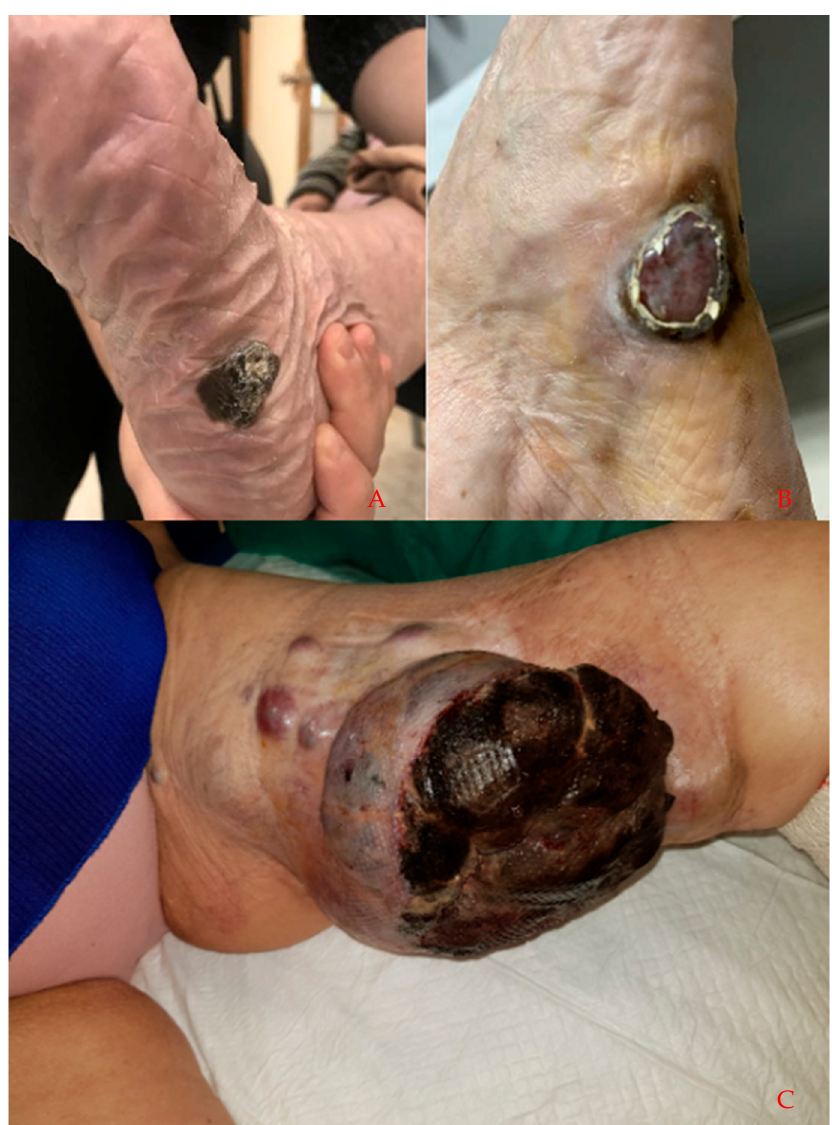
Figure 1. Clinical images of malignant melanoma diagnosed after the onset of the COVID-19 pan- demic. ( A ) 81-year-old female patient with a 3.2, nonulcerated melanoma. ( B ) 65-year-old male patient with a 4.1, ulcerated melanoma. ( C ) 54-year-old female patient with a locally advanced mela- noma.